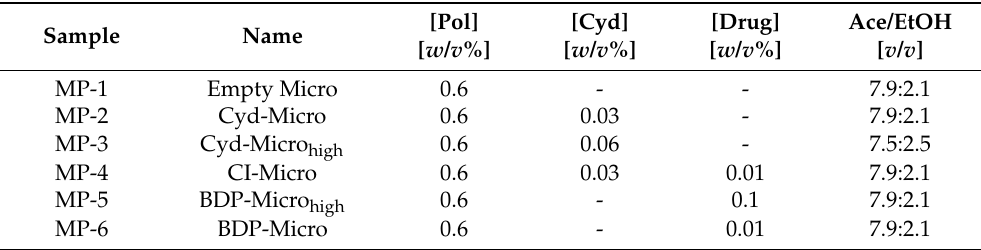
Table 1. Qualitative–quantitative composition of the liquid feed for the SD process for each MP